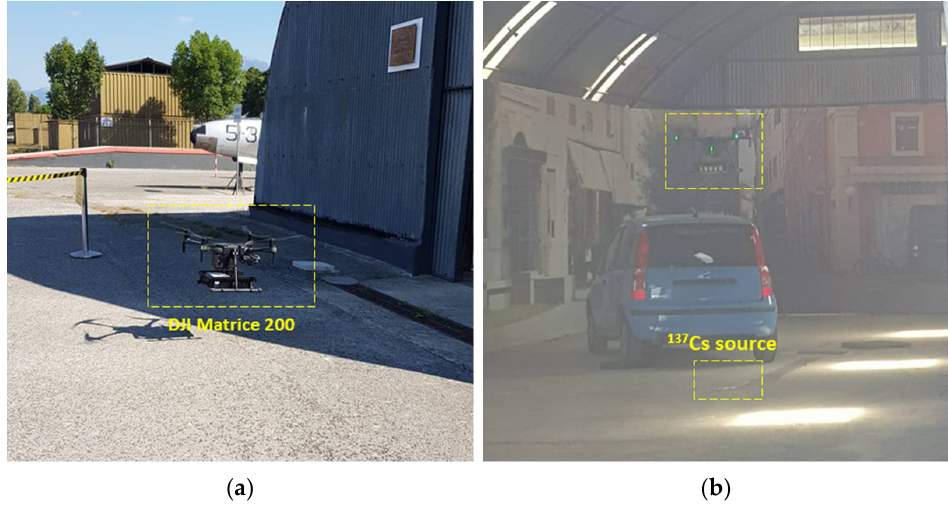
Figure 13. Tests conducted with a UAV mounting the detection units to assess the compatibility of the system with the use in flight. The UAV approaching the radioactive source ( a ); the UAV